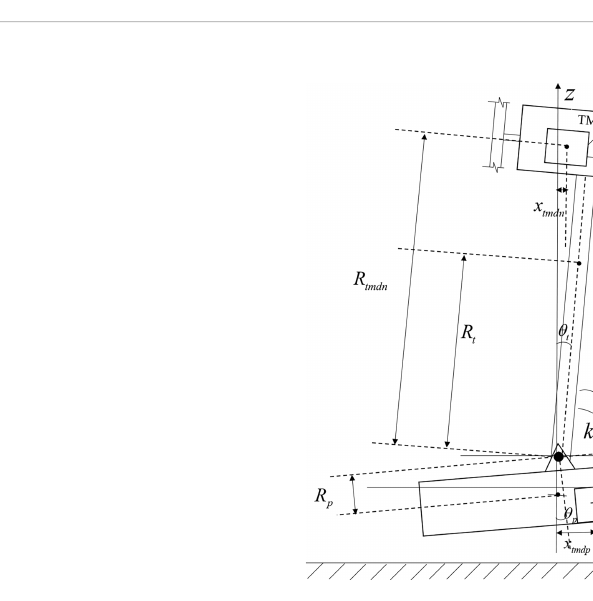
FIGURE 2 Simpli fi ed dynamic model of barge FOWT with MTMD in nacelle and